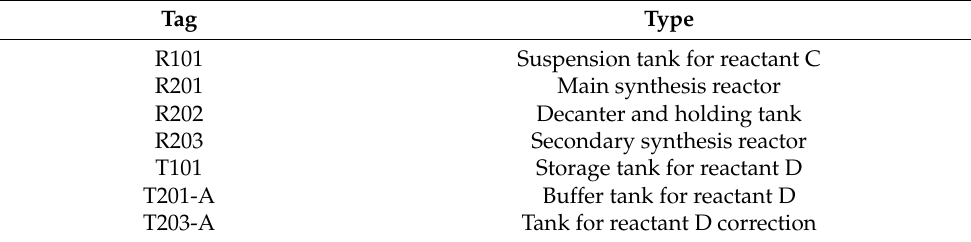
Figure 1. Simplified process flow diagram of the units involved in the reference industrial process. The grey-shaded blocks indicate the units involved in the multivariate modeling activities discussed in this study. Table 1. Main characteristics of the processing units.